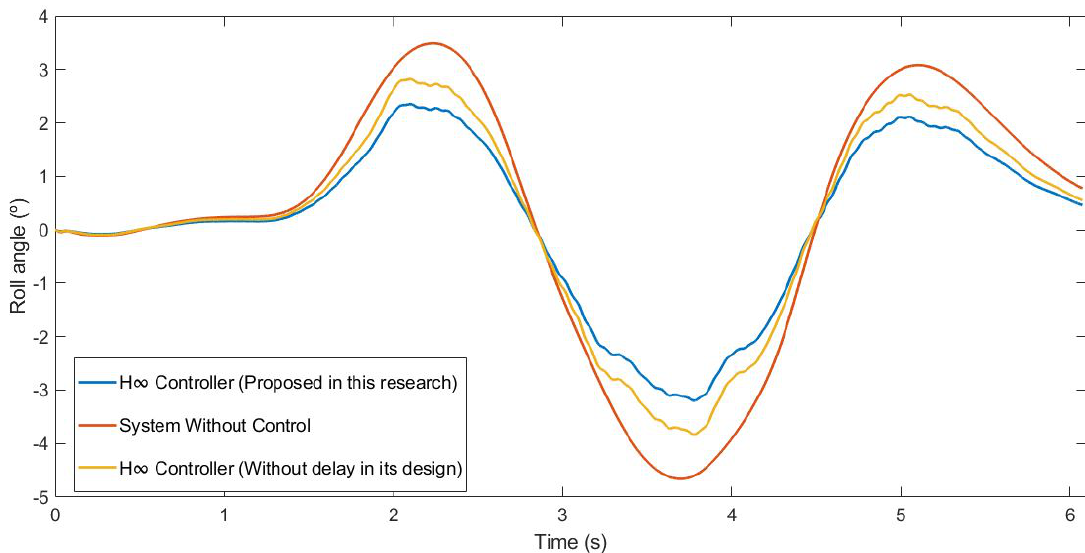
Figure 16. Roll angle for test 2: Double lane change at 100